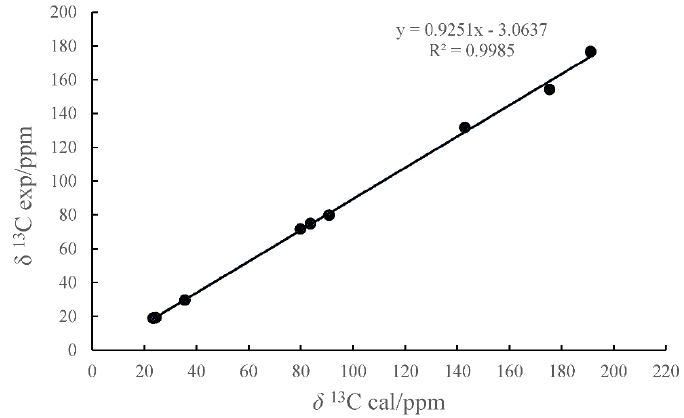
Figure 4. Calculated 13 C chemical shifts against the experimental data of 4 . Table 1. The 1 H, 13 C, HMBC, and HSQC NMR data for compound 4 in CD 3 OD.